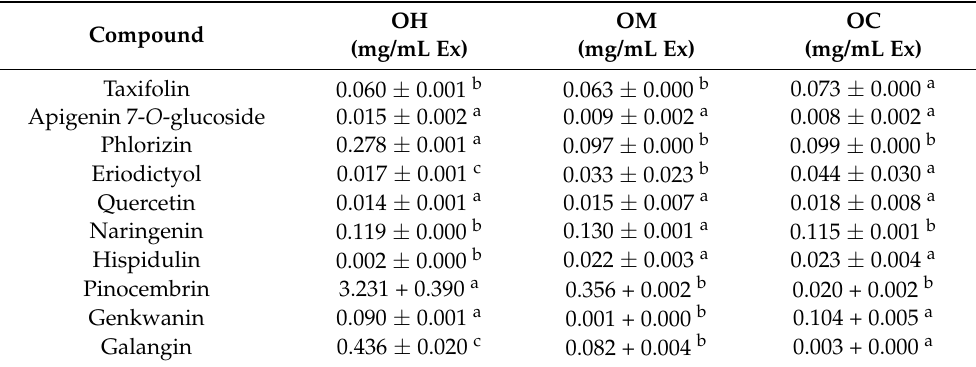
Figure 1. Representative chromatogram of phenolic compounds of Mexican oregano extracts from different regions of Jalisco state. ( a ) Oregano from Huejuquilla, ( b ) oregano from Mezquitic, ( c ) oregano from Colotlan. Table 5. Quantification of main phenolic compounds of Mexican oregano extracts from different regions of Jalisco